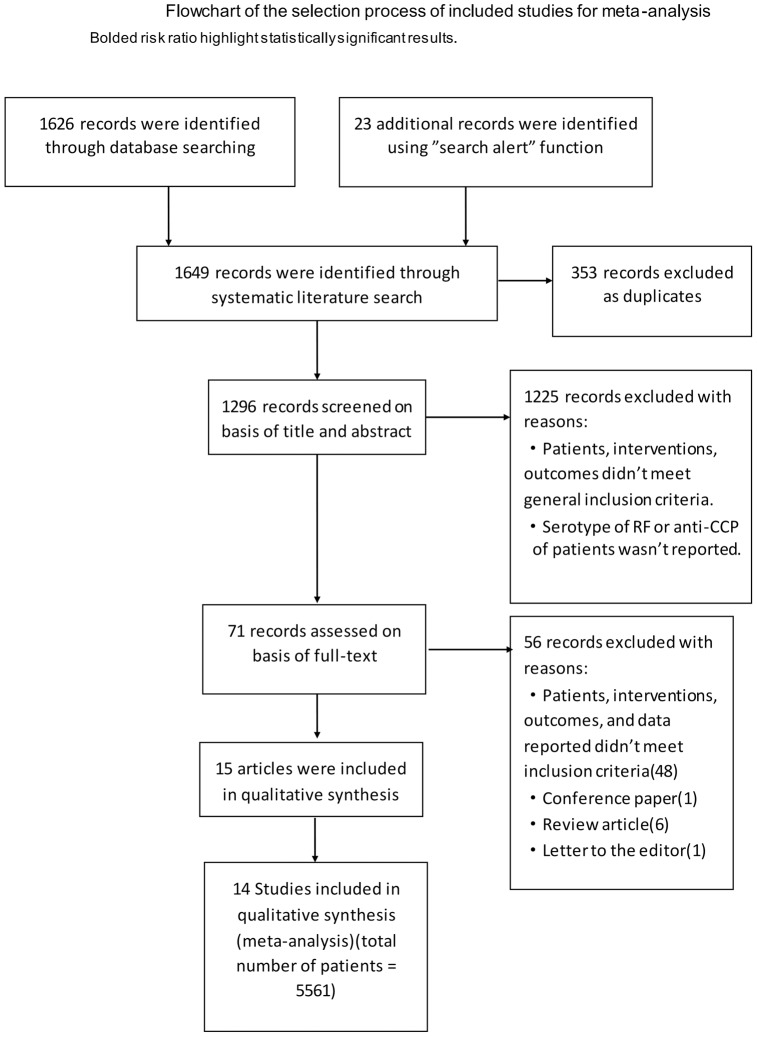
Flowchart of the study selection.